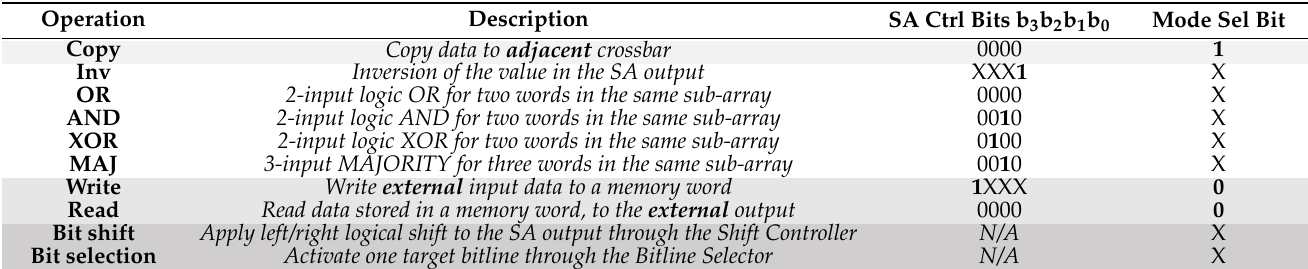
Table 2. Summary of operations supported by the proposed computational memory system. X means a don’t care value. Operation